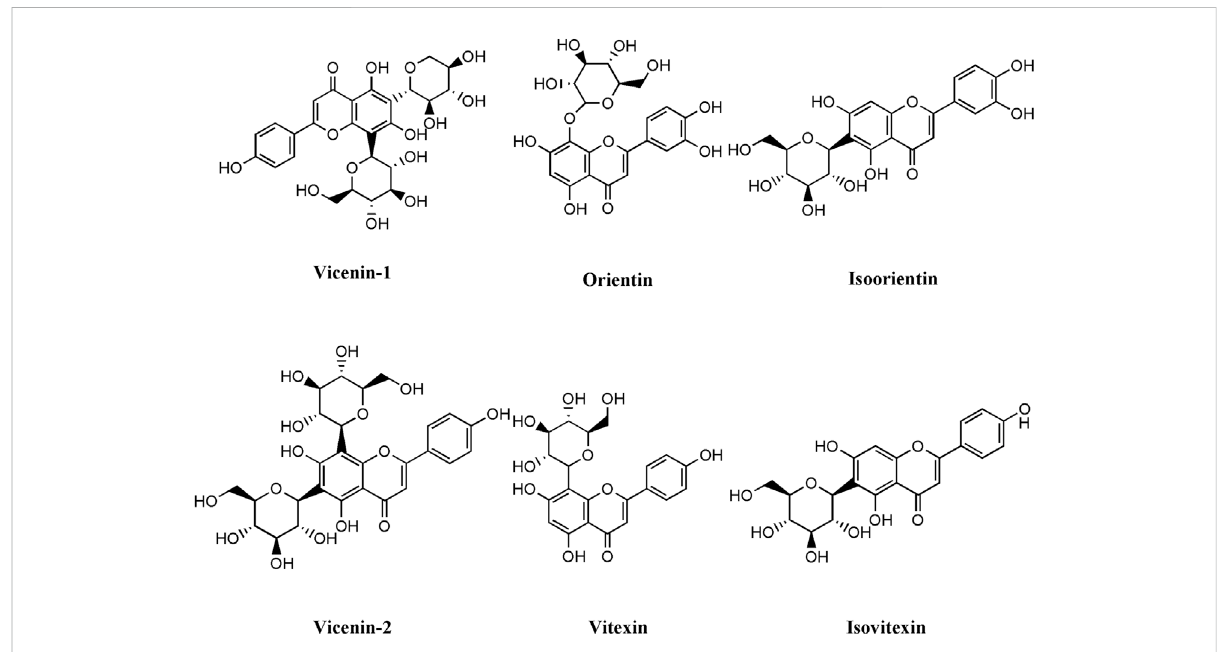
(Figure 3A). Despite this signi fi cant antioxidant-radical-scavenging activity of OSEE in the test tube in vitro (Figure 3A), we tested the effect of OSEE on ROS generation in MDA-MB-231 cells in culture.